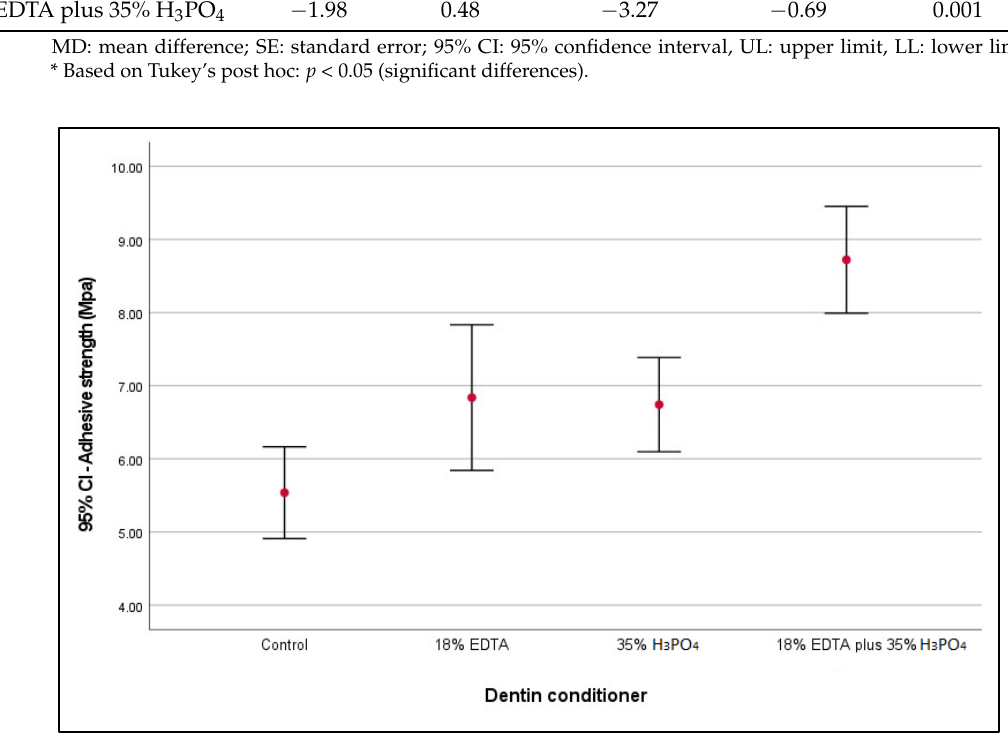
Figure 5. Comparison of means at 95% CI of adhesive strength (MPa) according to conditioner ap- plied.